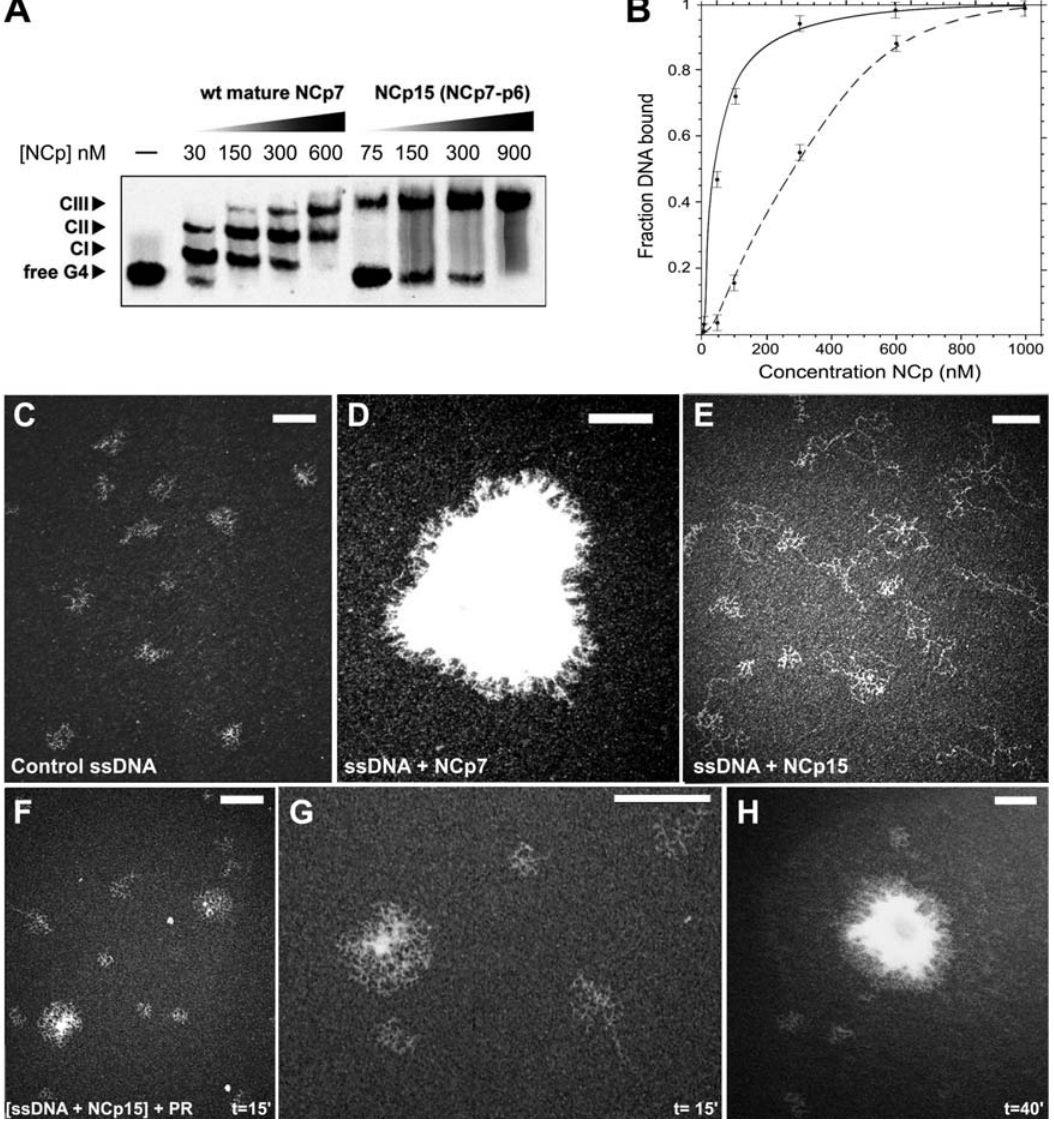
Figure 2. Differences in DNA binding between NCp15 and NCp7 and the effect of NCp15 proteolysis. (A,B) EMSA using G4-DNA (5 nM) and increasing amounts of NCp7 or NCp15. Complexes were formed for 15 min. at 37 u C before electrophoresis. Note that in the case of NCp15 there is only one shifted G4-DNA species (A), whereas quantification of the DNA bound fraction as a function of the total NCp concentration (B) shows a 6- fold drop in affinity for G4-DNA with NCp15 (solid line) compared to NCp7 (dashed line). (C,D,E) TEM visualization of ssDNA (5 nM) without protein (C) or with saturating amounts (3.4 m M) of NCp7 (D) or NCp15 (E). (F,G,H) TEM visualization of NCp15 proteolysis in the presence of ssDNA after 15 min. (F and G) and after 40 min. (H) incubation with saturating amounts of NCp bound to ssDNA and a NCp15-to-PR ratio of 30 corresponding to [NCp15]=3.4 m M, [PR]=100 nM and [ssDNA]=5 nM. The nascent aggregates revealed in (F) are shown with a higher magnification in (G). Scale bars in each panel correspond to 150